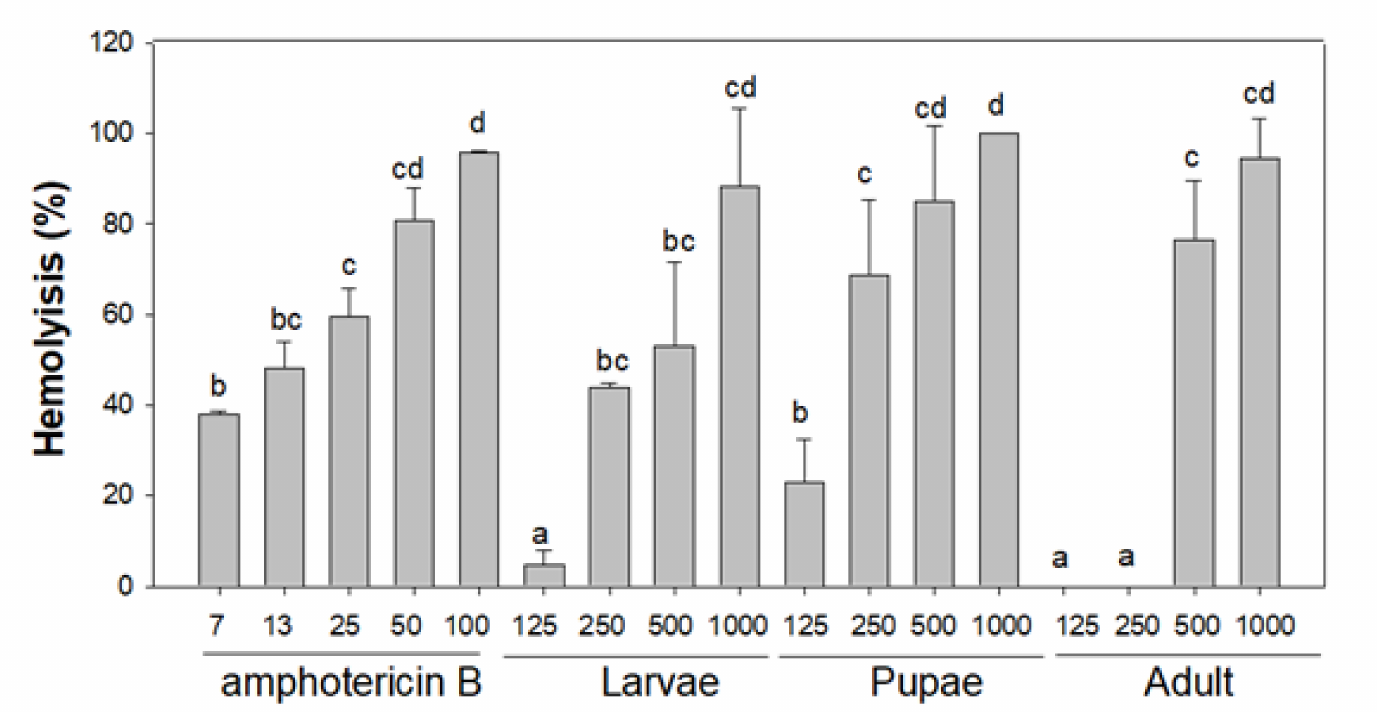
Figure 3. Haemolytic activities of the ethanol extracts of Buckfast honey bee drone; larvae, late pupae and adults from Denmark. Amphotericin B was used as positive control. Di ff erent superscripts indicate statistically significant di ff erences among treatment concentrations ( p <